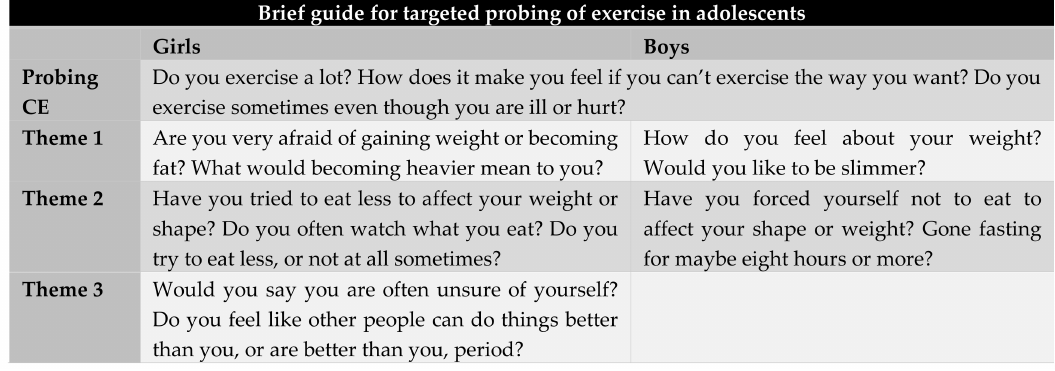
Figure 1. Brief guide for asking about eating disorder (ED)-related aspects in the presence of strenuous exercise, adapted from the items in the eating disorder examination questionnaire, and the structural analysis of social behavior that explained variance, in order of